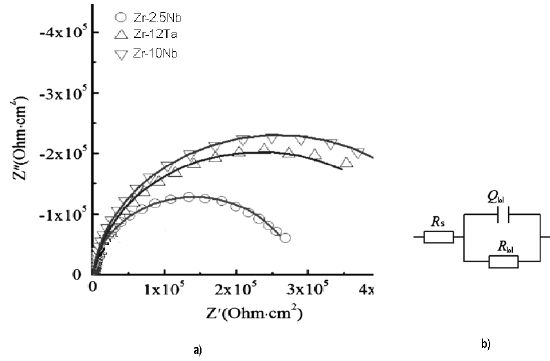
Figure 3. a) The Nyquist plots for all Zr-binary alloys in human female serum (line: fitted data, symbol: experimental data) and b) equivalent electrical